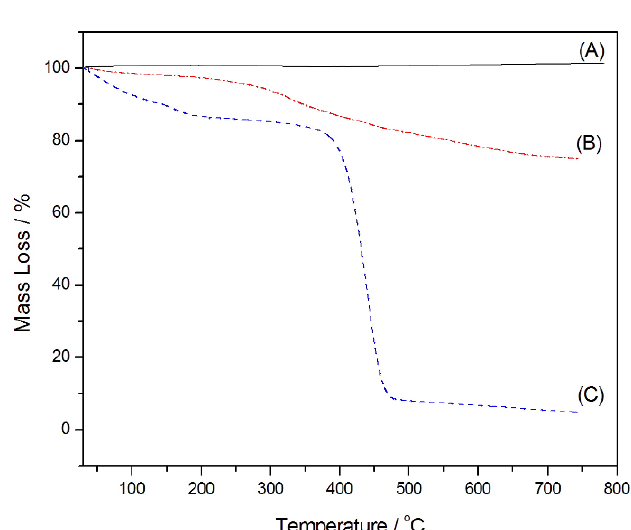
Figure 4. TGA thermograms of A) MNP B) PVIgMNP and C) Si-PVI.